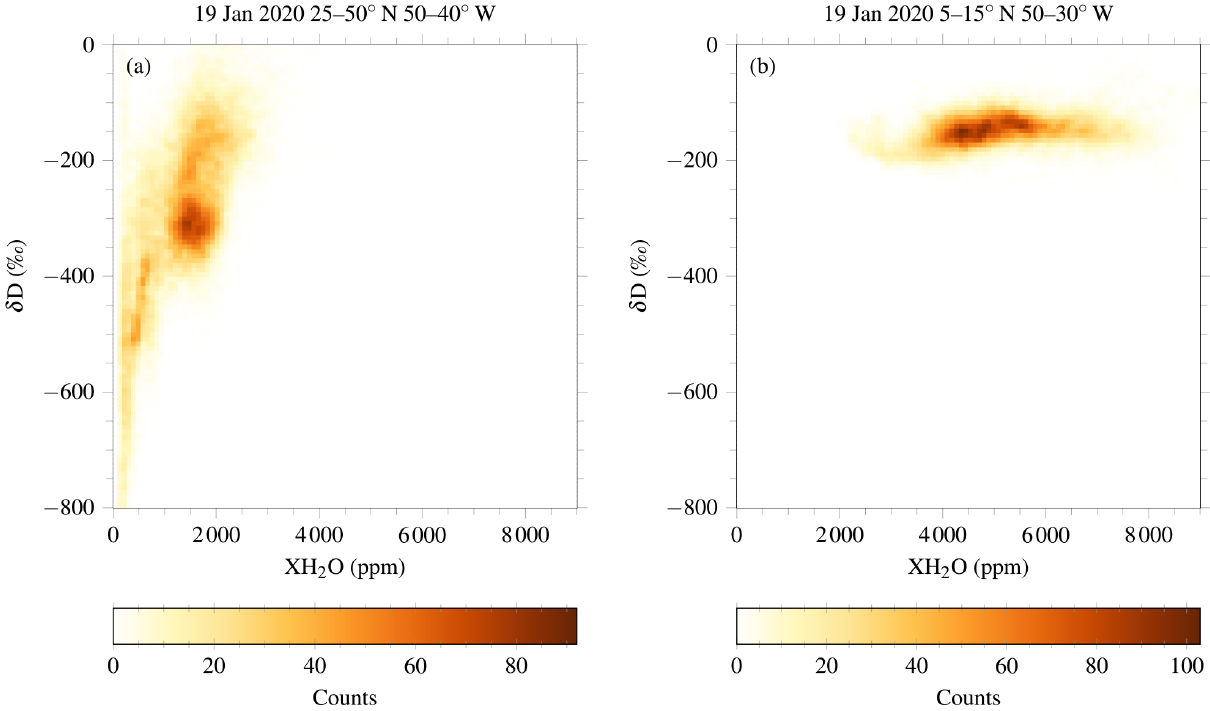
Figure 21. Histograms of TROPOMI observations on 19 January 2020 (a) in the area 25–50 ◦ N, 50–40 ◦ W comprising the cold sector and (b) in the area 5–15 ◦ N, 50–30 ◦ W containing the cold